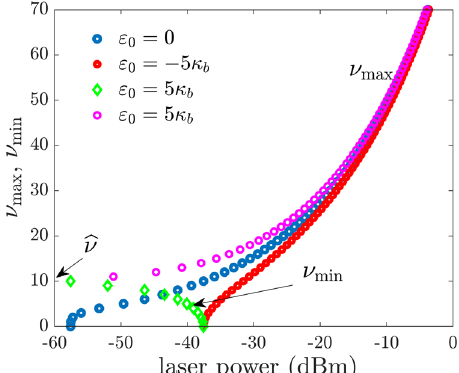
Fig. 5 Maximal and minimal optical parametric oscillator (OPO) sideband orders achievable by the pump-frequency scan. The pump power dependencies of the maximal, ν max , and minimal, ν min , mode numbers corresponding to the ± ν OPO states that can be generated by the pump- frequency tuning method. ν min is different from zero only for ε 0 > 0. b ν (cid:5) ffiffiffiffiffiffiffiffiffiffiffiffiffiffiffiffiffiffi p corresponds to the lowest possible excitation threshold for (cid:1) ε 0 = D 2 a ε 0 > 0, see text between Eqs. (18) and (19). Dispersion is normal, see Fig. 1 for other